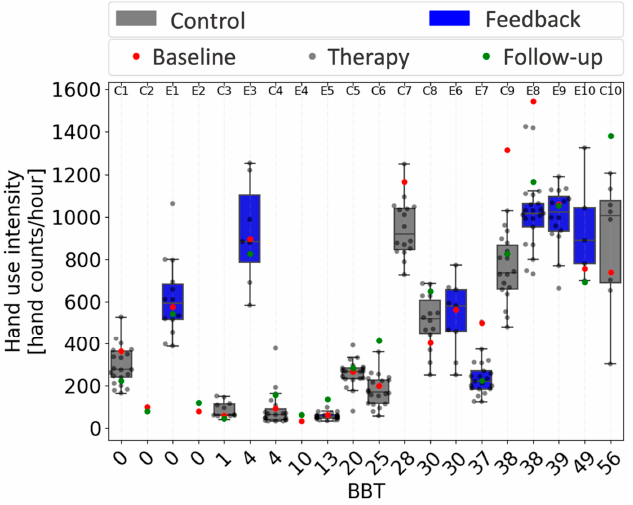
Figure 8. Relationship between hand use intensity and Box and Block Test (BBT) score. Each circle represents the average hourly count for one day. Participants are ordered by BBT. The box and whisker plots use bars to show the 25% and 75% percentiles of daily hand use intensity, and lines to show these quartiles plus and minus the interquartile range. Thus, the plots indicate the individ- ual distribution of daily hand use intensity across the three weeks of therapy for participants in both groups (control in gray, feedback in blue). Box and whisker plots do not include baseline and follow- up data, which are indicated by red and green dots, respectively. Subject numbers are presented on the top, with Es for participants in the feedback group and Cs for participants in the control group. Note that the x -axis is equally spaced and not scaled to BBT score.